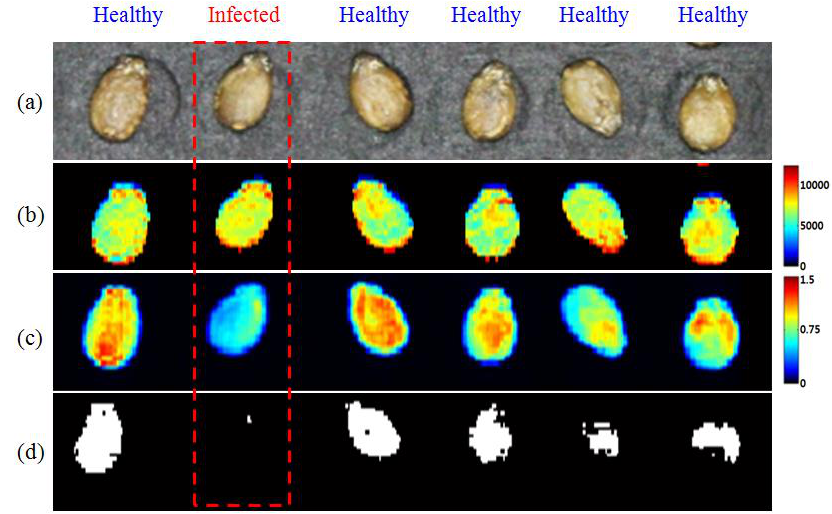
Figure 7. Comparison of the resultant images obtained by using the Raman hyperspectral image; ( a ) original picture of seed samples, ( b ) representative Raman images at 1076.8 cm − 1 , ( c ) a band-ratio image (1076.8 cm − 1 /437 cm − 1 ), ( d ) a binary band-ratio image with a threshold value of 1.03.